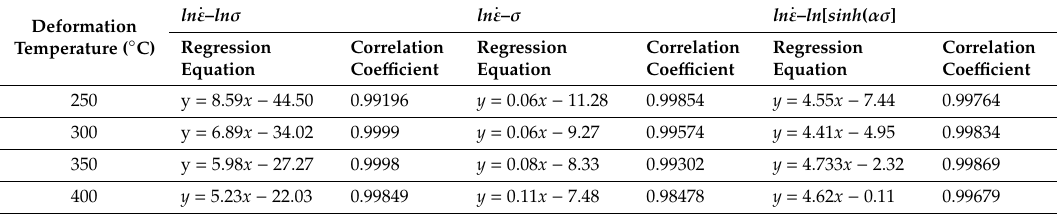
Table 2. Statistics for the linear regression between ln TiB